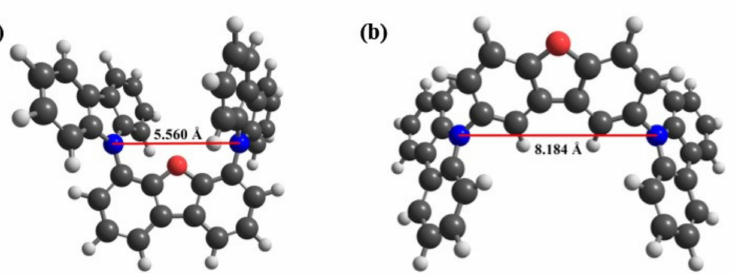
Figure 4. The calculated distance between the nitrogen atoms of the ( a ) 46CzDBF and ( b ) 28CzDBF.